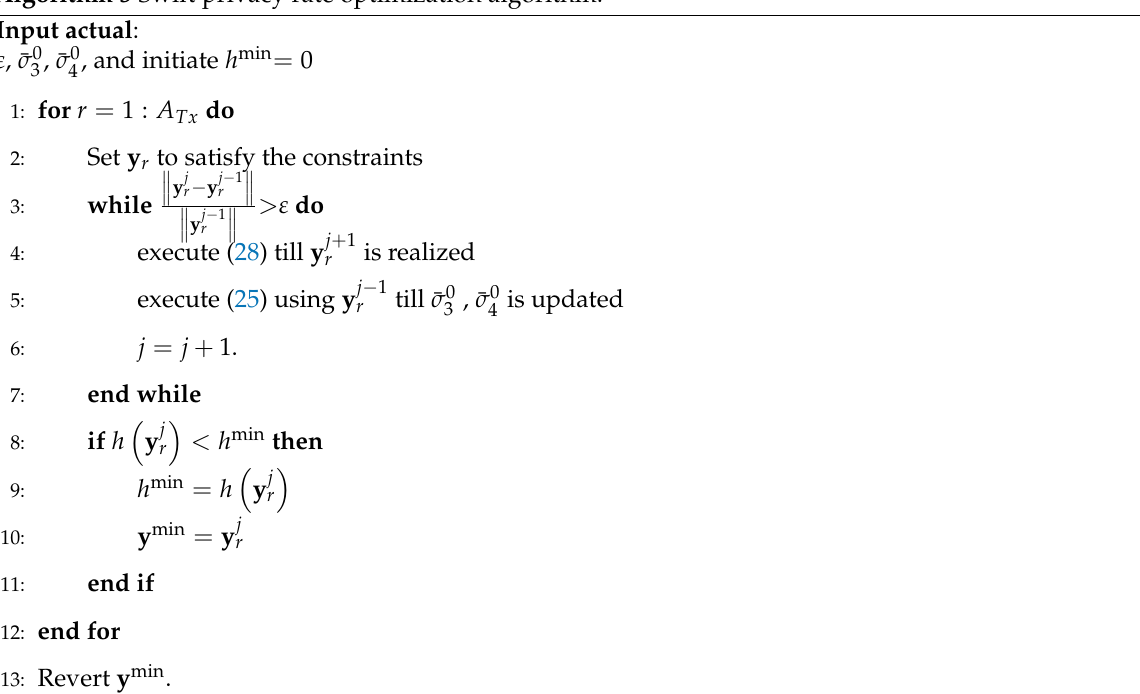
Algorithm 3 Swift privacy rate optimization